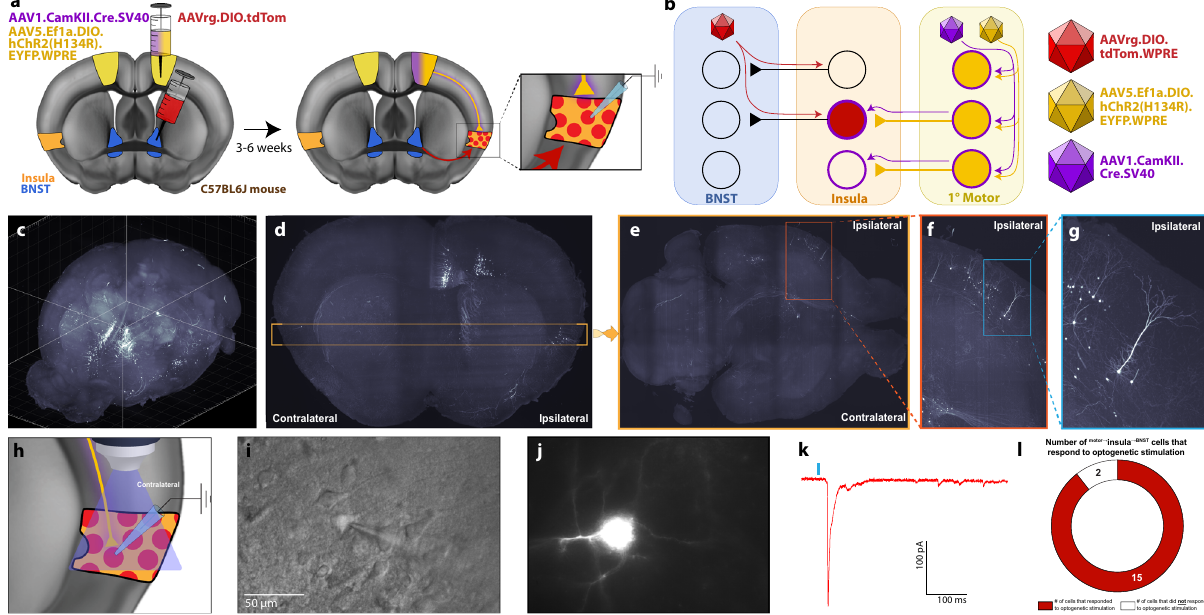
Fig. 8 Motor efferents directly synapse onto and activate insula → BNST cells. a Diagram of the viral injections to isolate the 1°Motor → insula → BNST cells. A 1:1 ratio of AAV1.Cre (purple) and AAV5.DIO.ChR2.EYFP (yellow-green) were injected into the motor cortex. AAVrg.DIO.tdTomato (red) was injected into